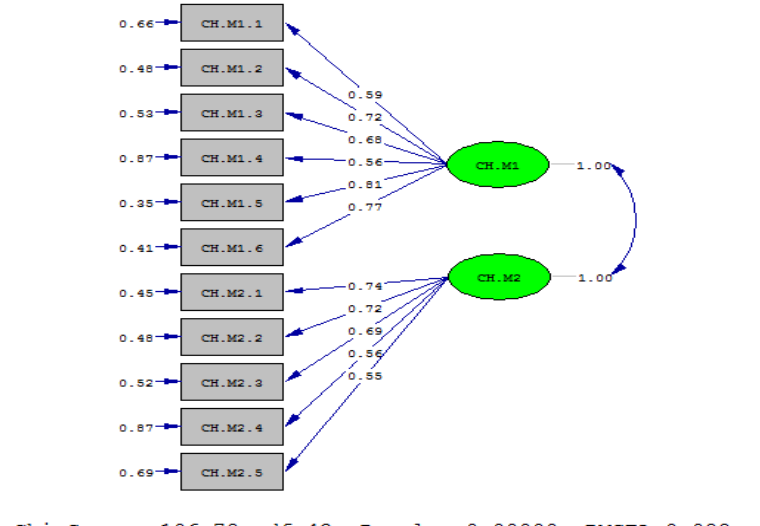
Fig. 2. Confirmatory factor analysis for transformational leadership